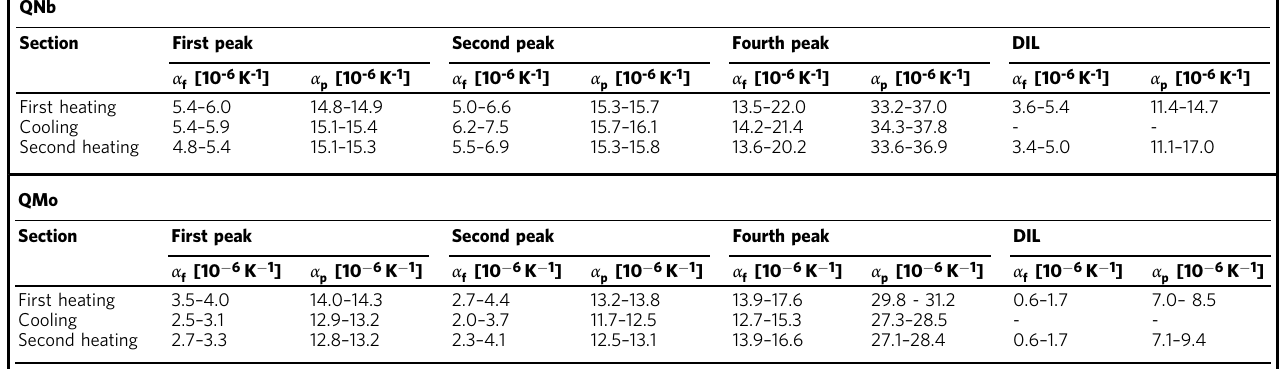
Table 1 Coef fi cient of thermal expansion of QNb and QMo measured by XRD and dilatometry